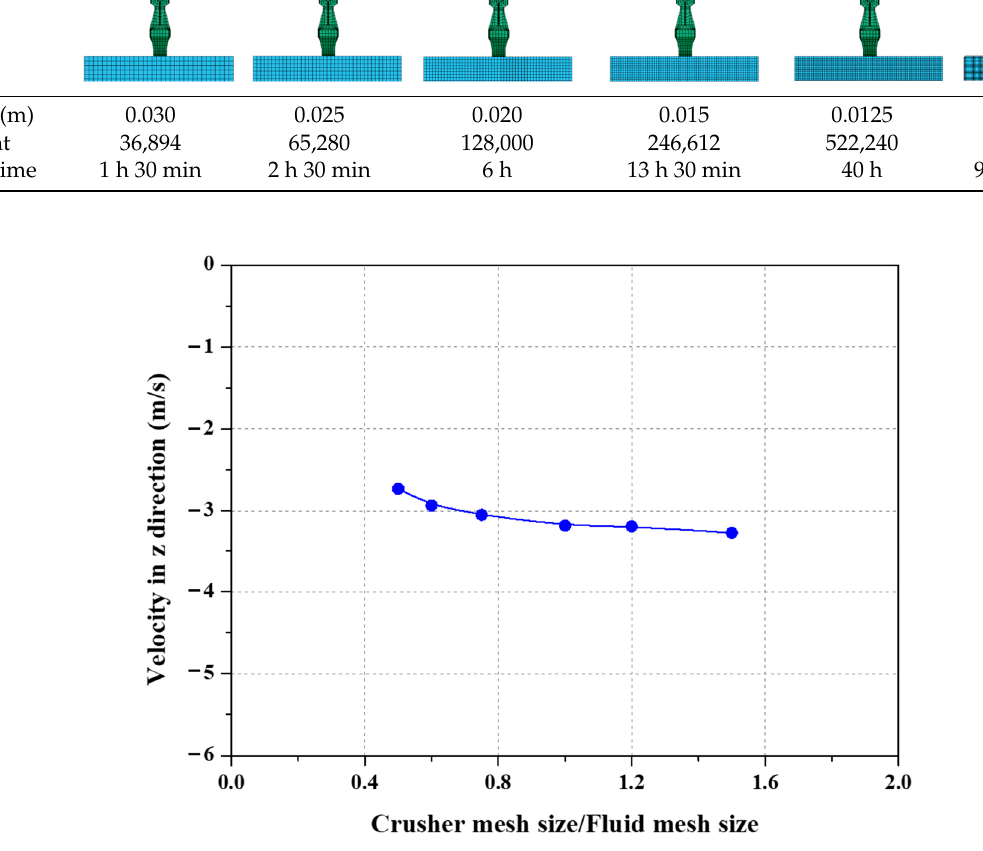
Figure 11. The effect of fluid mesh size.